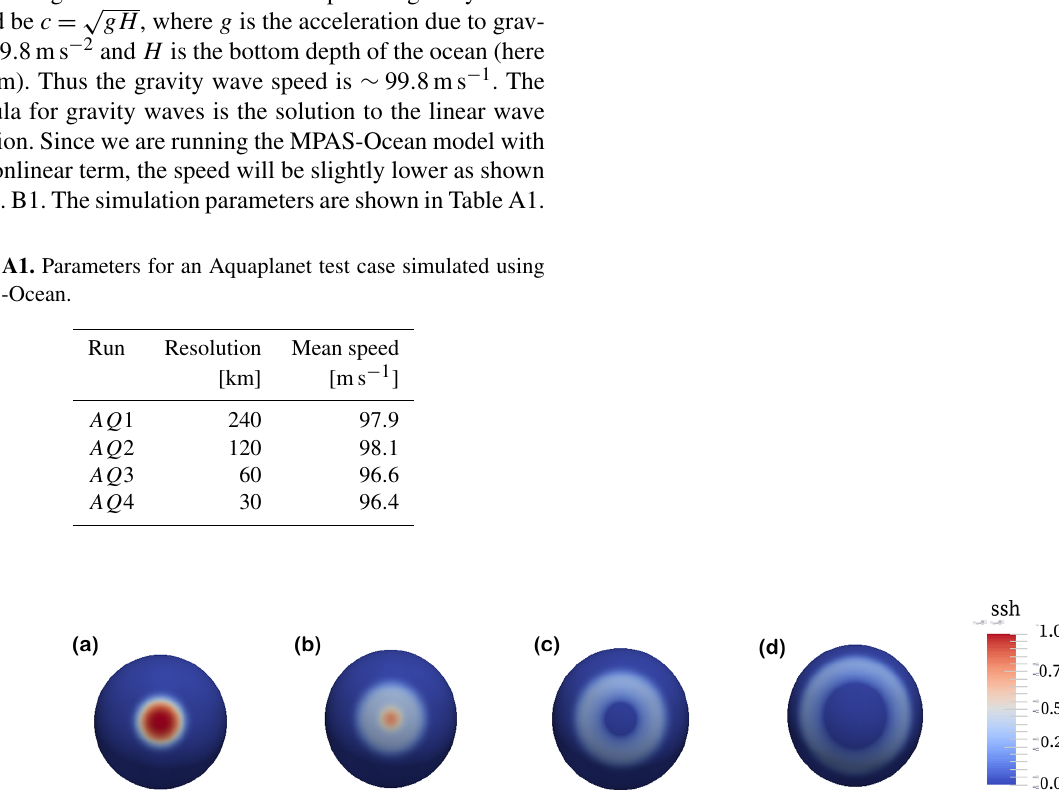
Figure A1. Surface gravity wave on a sphere initiated by a Gaussian hump in sea surface height (ssh, m), at (a) t = 0s, (b) t = 3 . 7s, (c) t = 6 . 1s and (d) t =